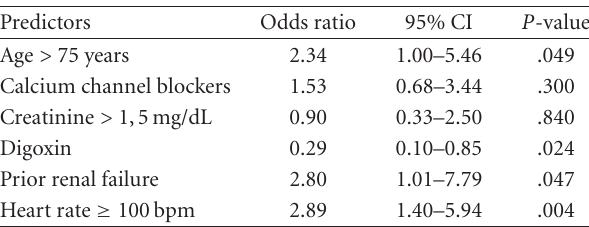
Table 2: Predictors of WRF (CRE): multivariable analysis.